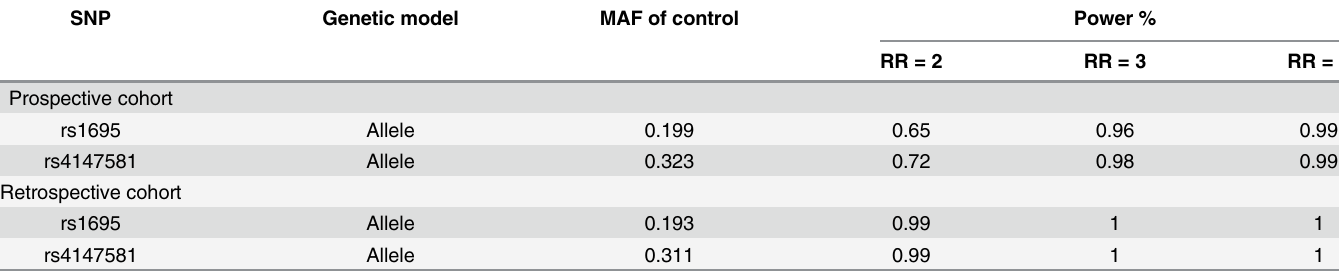
Table 4. Power of the study with different relative risks